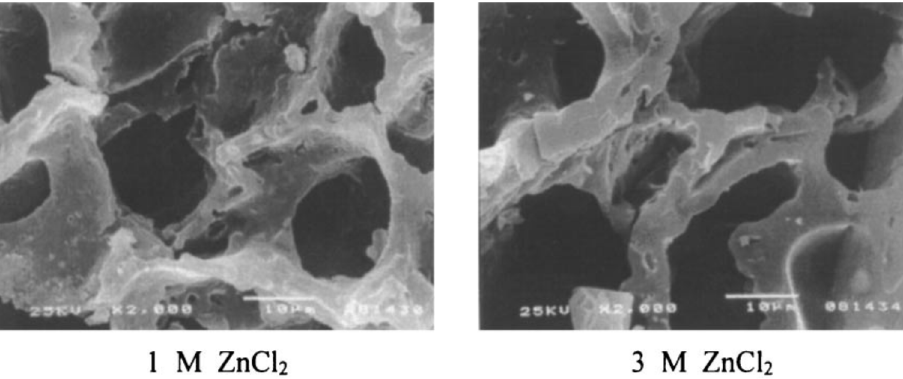
Figure 7. SEM images of activated carbon using 1.0 M and 3.0 M ZnCl 2 . Reproduced with permission from [15], ©2001 Elsevier Science B.V.